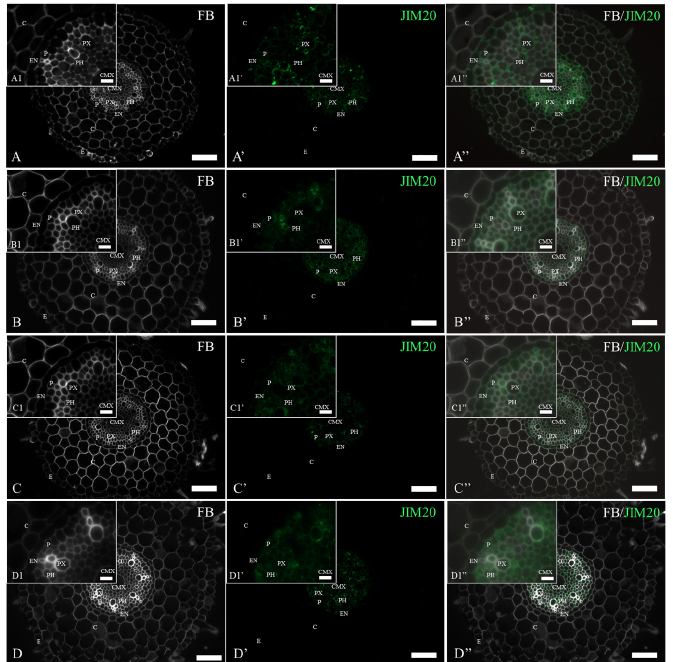
Figure A1. Immunolocalization of the JIM20 epitope ( A – D ) in cross-sections of the B. distachyon roots, ( A , A’ , A” ): the control; ( B , B’ , B” ): 250 µM 3,4-DHP; ( C , C’ , C” ): 500 µM 3,4-DHP, ( D , D’ , D” ): 750 µM 3,4-DHP. Abbreviations: C—cortex, CMX—central metaxylem, E—epidermis, EN—endodermis, FB—fluorescent brightener, P—pericycle, PH—phloem, and PX—protoxylem. The green color shows epitope occurrence. Scale bars: 10 µ m for A1–C1, while for the remaining photomicrographs, 50 µ m.